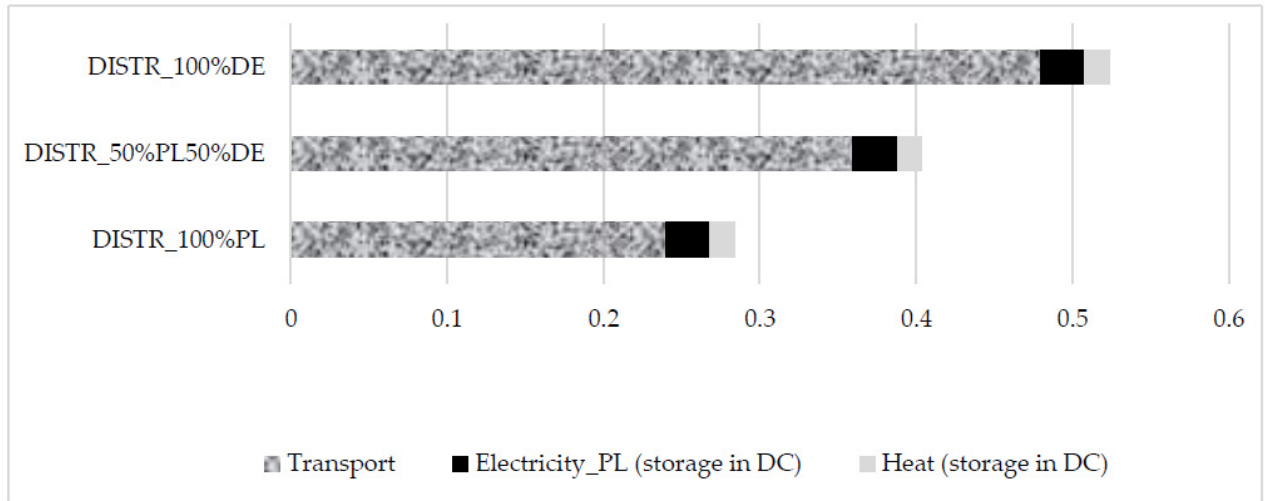
Figure 3. Environmental impact of the life cycle stage Distribution (DISTR) per 1 refrigerator (0.523 Pt = 100%DE, 0.404 Pt = 50%PL50%DE, 0.284 Pt = 100% PL, decrease by 46%).